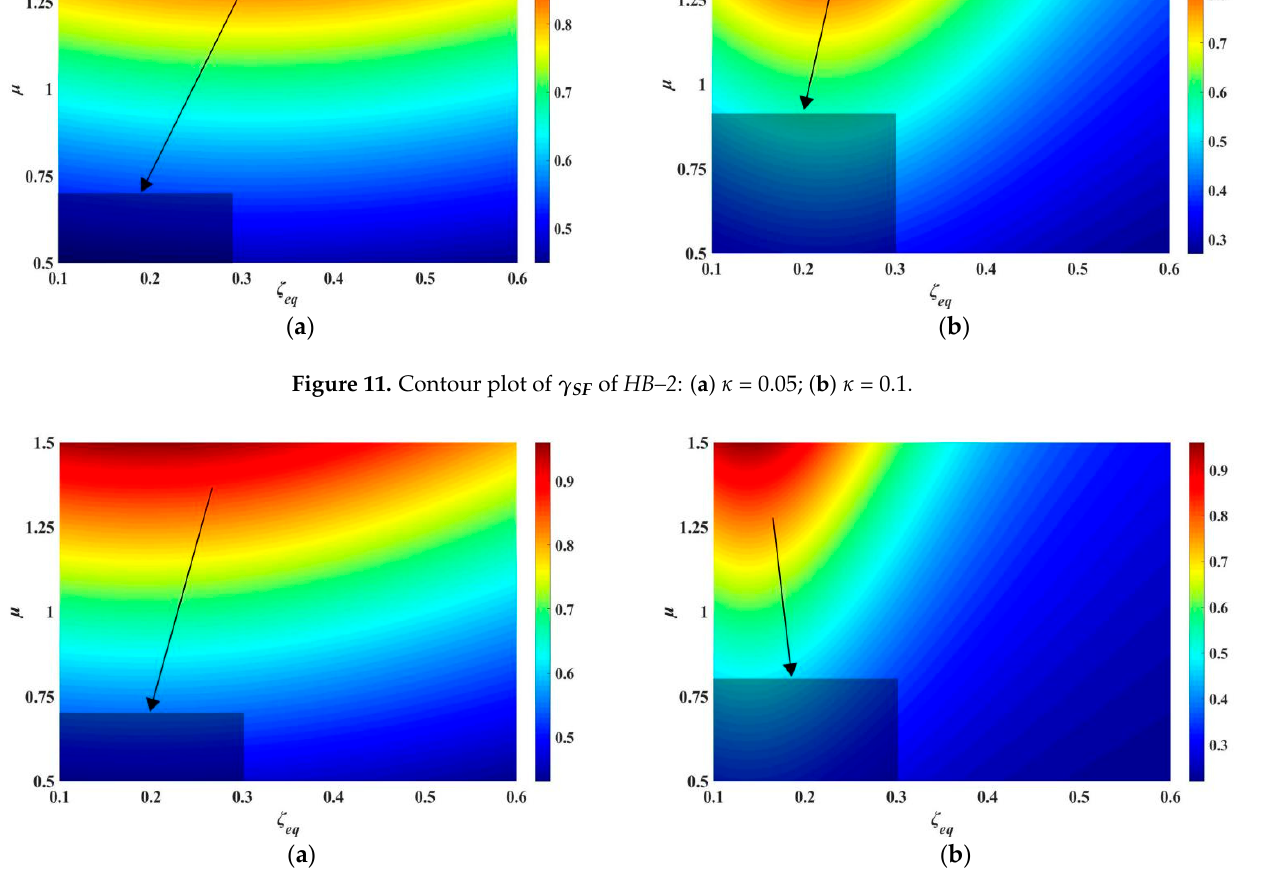
( b ) Figure 13. Contour plot of γ SF of LB–2 : ( a ) κ = 0.05; ( b ) κ = 0.1 . The base shear force of the tank of the IIS is lower than IB when the inerter–mass ratio is within [0.5,1.5], but when the inerter–mass ratio is greater than 1.5, the base shear force of IB is less than IIS, indicating that the large inertance coefficient will increase the force output of the isolation layer. This trend is opposite to γ U and γ ID . Therefore, under the condition of meeting the displacement index ( γ U and γ ID ), the inerter–mass ratio should be reduced as much as possible to reduce the base shear force. Fix γ SF = 0.5 and the damping ratio is less than 0.5 as the target area in Figures 10–14 (rectangular shadow). It can be seen that when the frequency ratio is 0.05, the target area is smaller and the corresponding optional parameter range becomes smaller for both bushings with low frequency and bushings with high frequency; when the frequency ratio increases to 0.1, the target area increases significantly, and the range of selectable reason- able inerter–mass ratios also expands. At the same time, it can also be seen that the target area of bushings with high frequency is larger than bushings with low frequency, so the bushings with high–frequency difficulty provide easier control over base shear force.